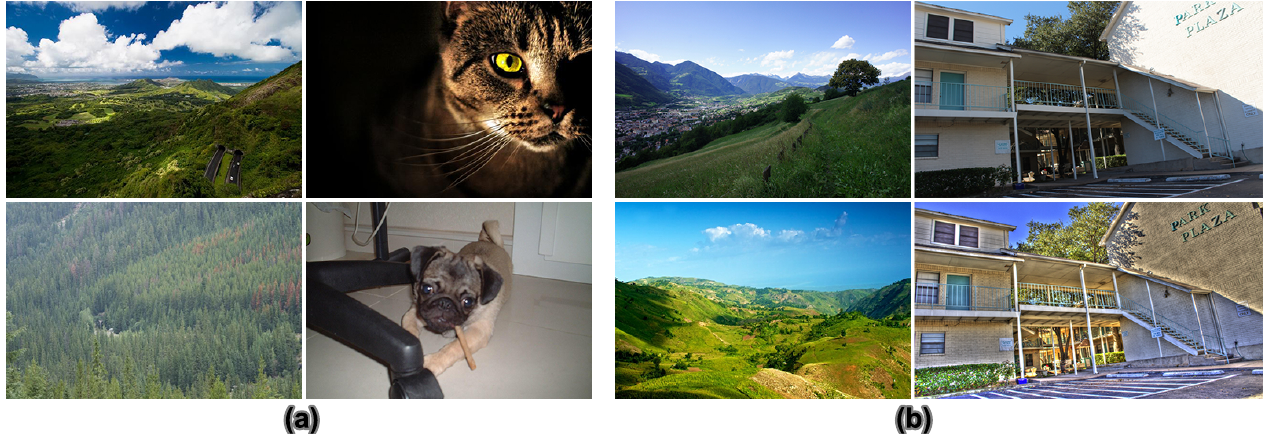
Figure 2. Examples of intrinsic properties. The first photo has a higher resolution than the others, while the color depth of the third photo is shallower than those of the two first ones.